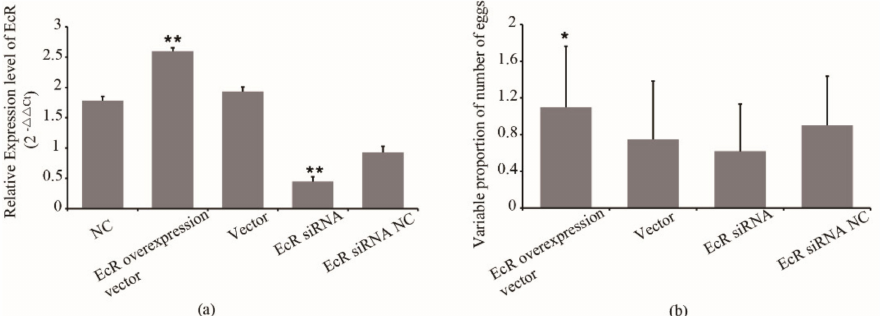
Figure 3. ( a ) The expression of EcR in queens after treatment and ( b ) the effect of its expression on the egg number of queens. EcR siRNA NC, EcR siRNA nonsense sequence control. Normal control, queens without treatment. * means p < 0.05, ** means p <